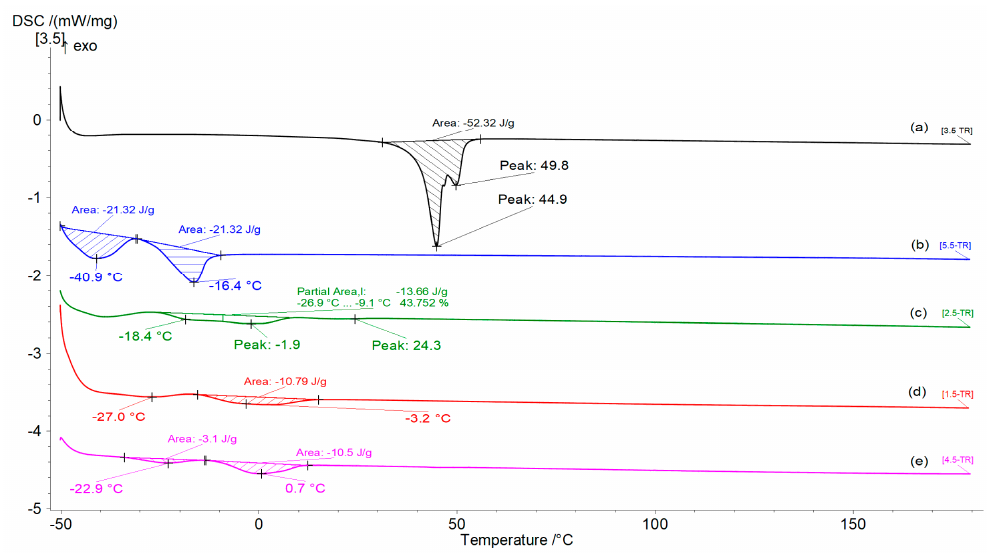
Figure 5. DSC thermograms of the samples ( a ) (BDO-AA)n, ( b ) (Gly-AZA)n, ( c ) ESO-BDO, ( d ) ECO-SORB, and ( e ) EPX-OIL. Table 5. DSC parameters of the oligoesters and plasticizers .